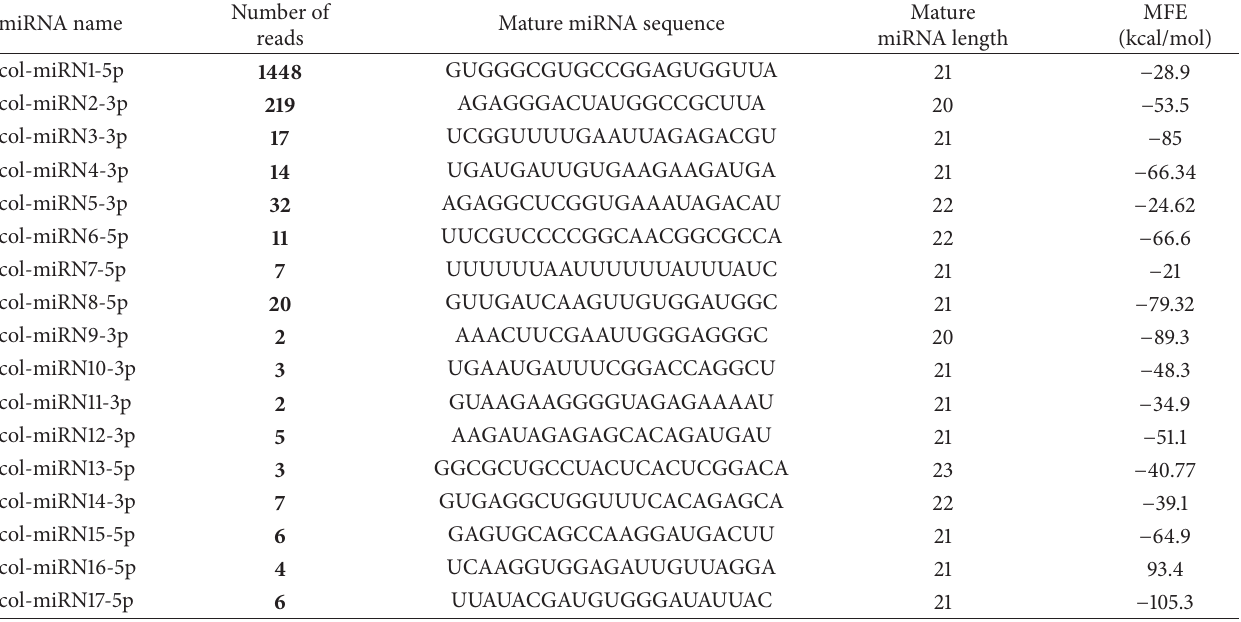
Table 3: Potential novel miRNAs found in jute.